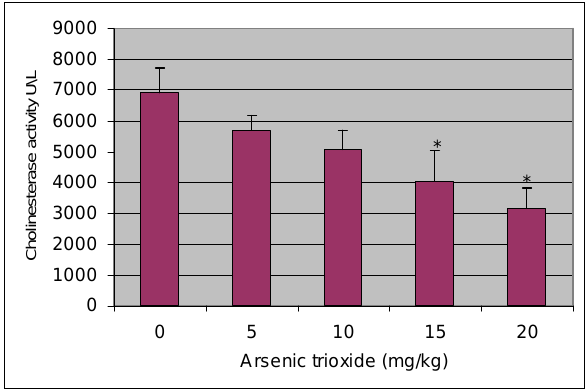
Figure 1: Effect of Arsenic trioxide on the activity of serum cholinesterase in Sprague-Dawley